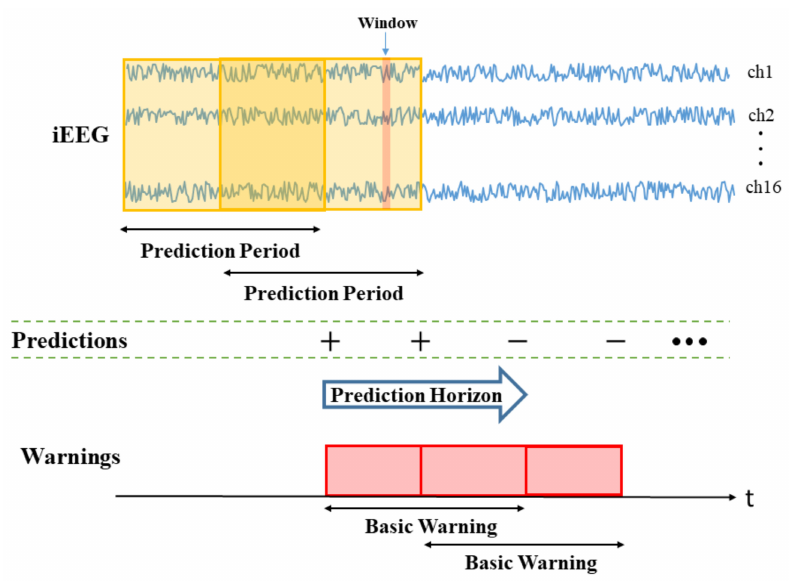
Figure 3. Systemdesignparametersforonlineprediction: